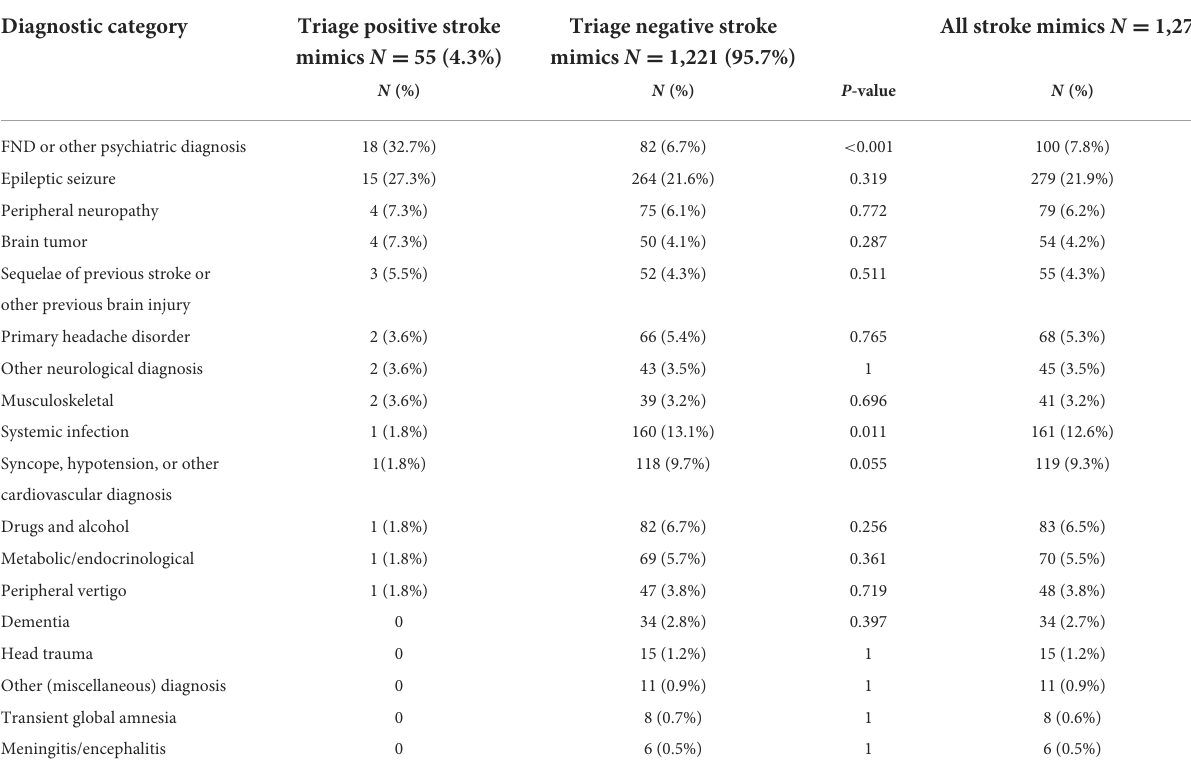
TABLE 3 Comparison of diagnostic category distribution between patients with triage-positive mimic and those with triage-negative stroke mimic. Diagnostic